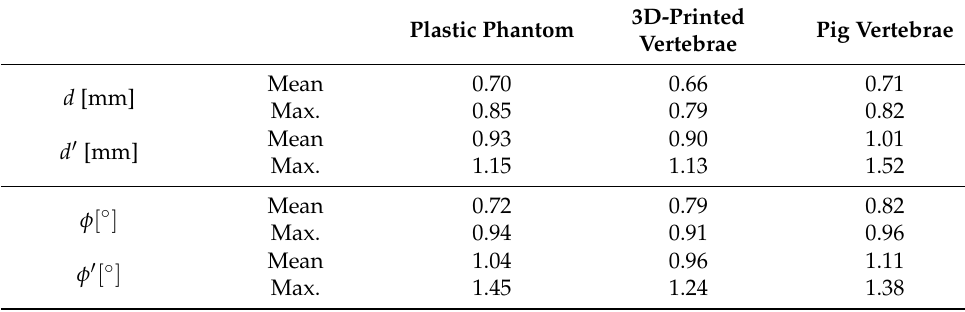
Figure 9. Overall system accuracy study: ( a ) the 3D-printed vertebra and pig vertebrae; ( b ) the CT image of the animal vertebrae after drilling; ( c ) the box plots of distance deviation and incline angle. Table 4. Overall system accuracy